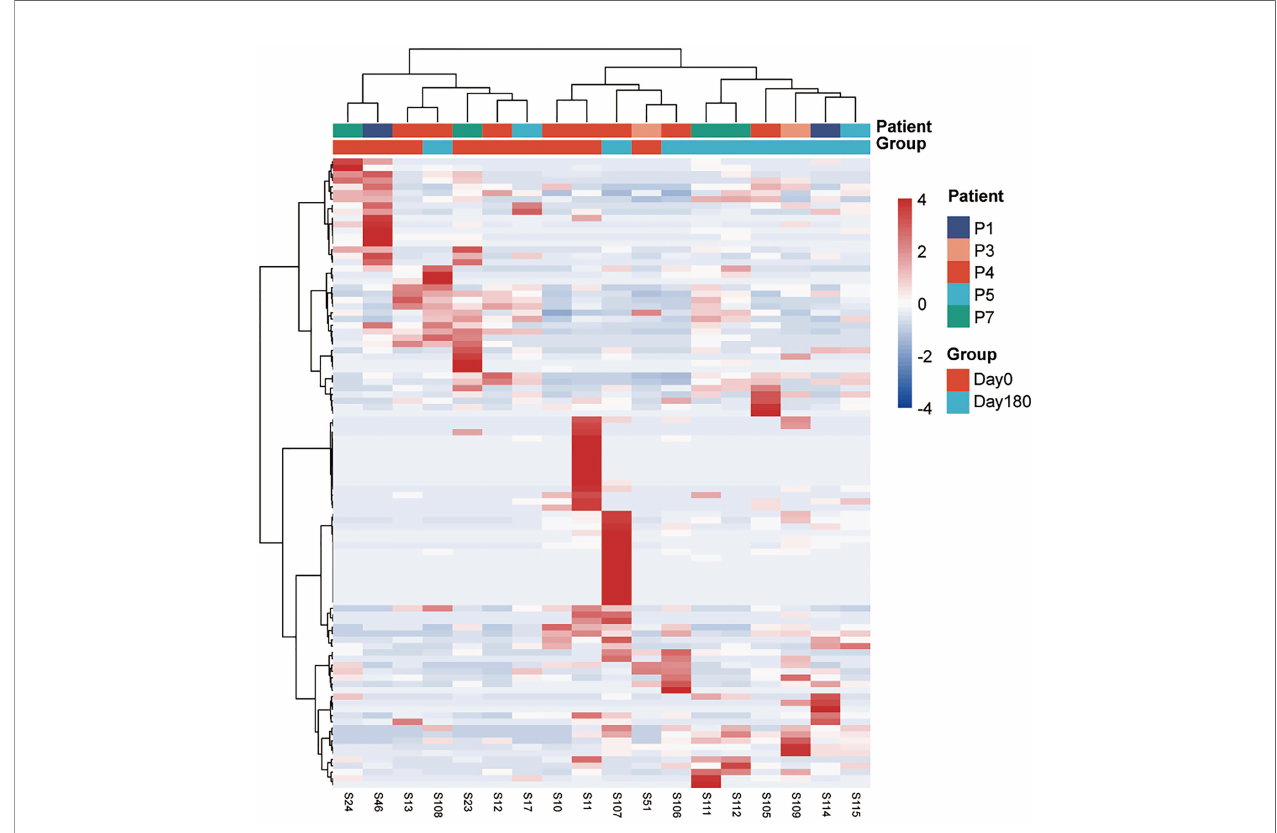
FIGURE 4 | A heatmap of the relative abundances of ASVs between the 180 days after-treatment group and pre-treatment group (day 0). The top panel shows hierarchical Ward-linkage clustering based on Ward.D distance of all the 18 samples, colored by the groups and patients. The left panel shows hierarchical Ward- linkage clustering based on Pearson correlation coef fi cients of the